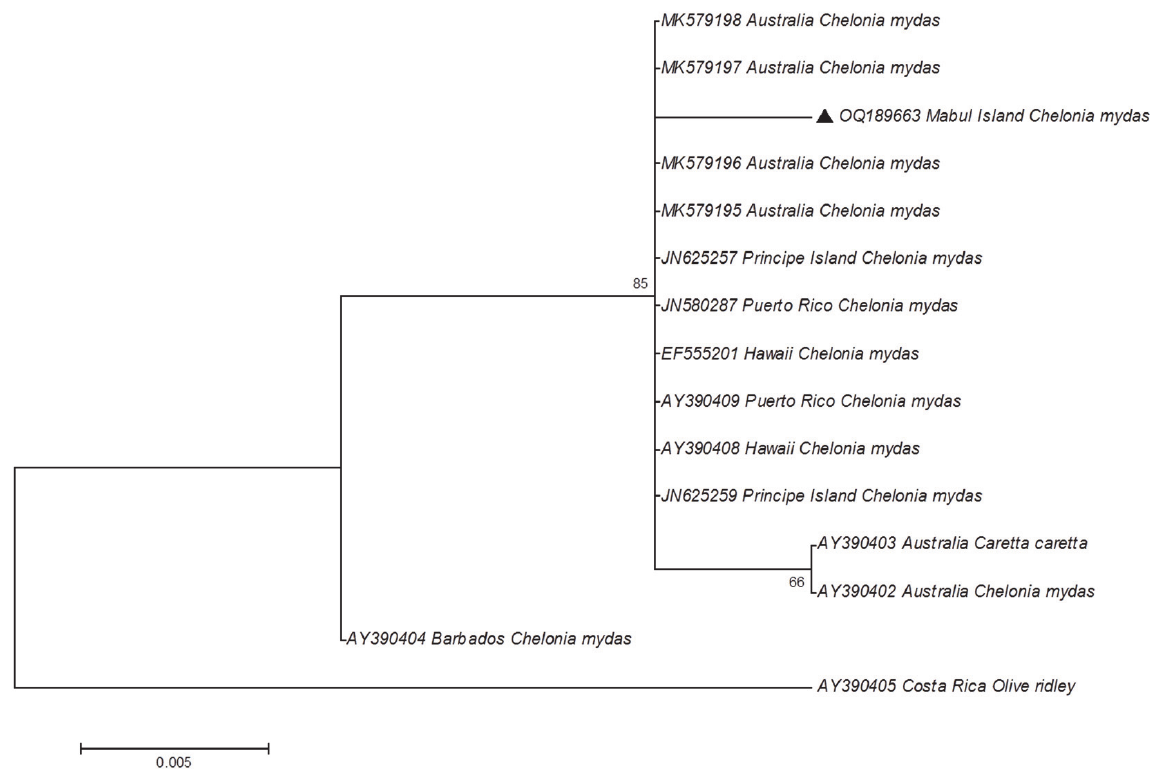
Figure 4. Phylogenetic tree of ChHV5 partial glycoprotein b variants inferred using the maximum likelihood method (Tamura’s three-parameter). The sample from this study is indicated with a black triangle.